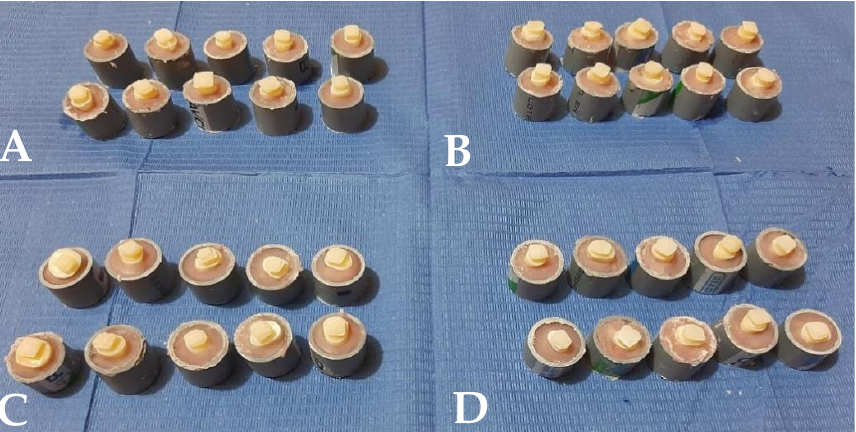
Figure 2. Sample units according to study group. ( A ) No dentin conditioning (Control), ( B ) dentin conditioned with 18% EDTA, ( C ) dentin conditioned with 35% H 3 PO 4 and ( D ) dentin conditioned with 18% EDTA plus 35% H 3 PO 4 .